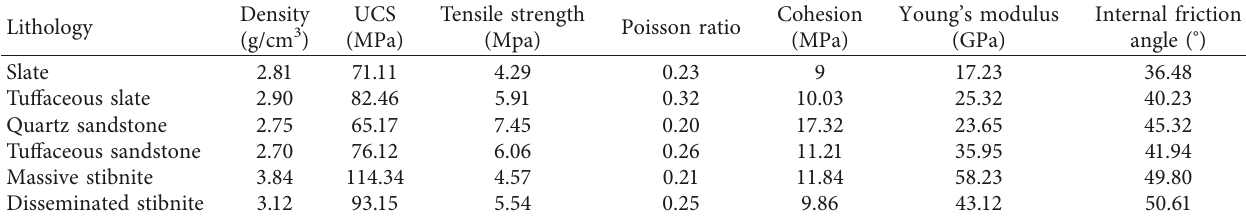
Table 2: Physical and mechanical properties of